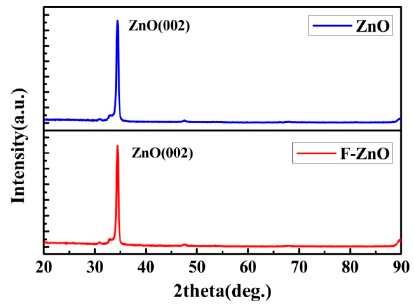
Figure 1. The X-ray diffraction (XRD) of ZnO films with and without SF 6 plasma treatment.